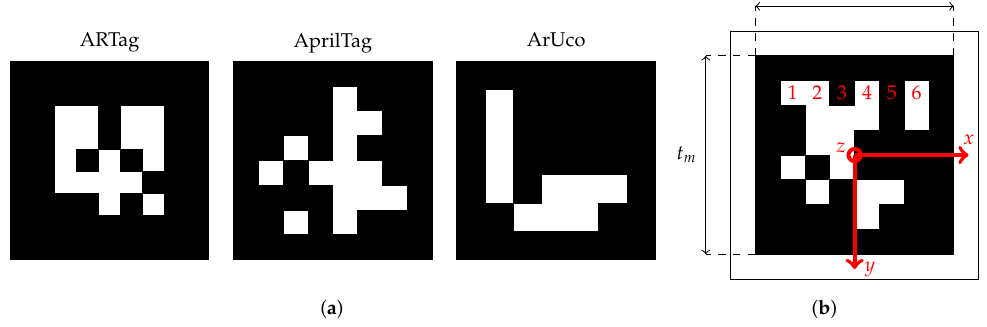
Figure 2. Types and structures of different visual Fiducial tags: ( a ) ARTag (left), AprilTag (center), and ArUco (right), and ( b ) shape, general structure, and coordinate system of an AprilTag of family 36h11 (here: ID